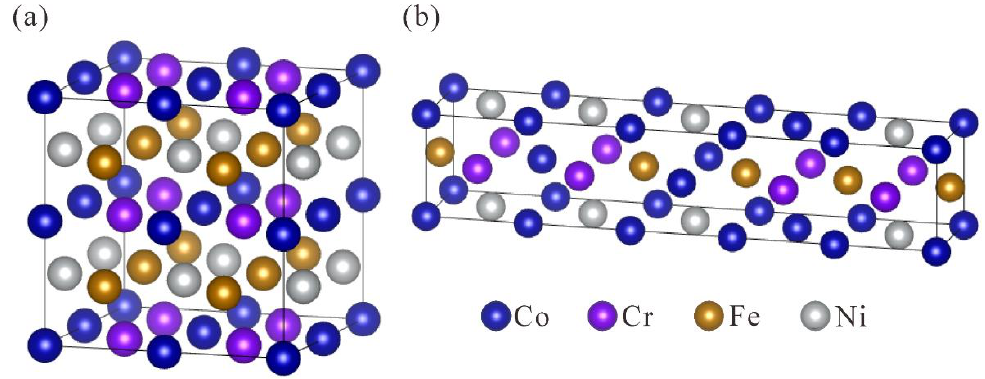
Figure 1. Co-Cr-Fe-Ni HEAs’ structures of supercell solid-solution alloy models. ( a ) The values of x are 0.2, 0.56, 1 and 1.57; ( b ) the value of x is 2.